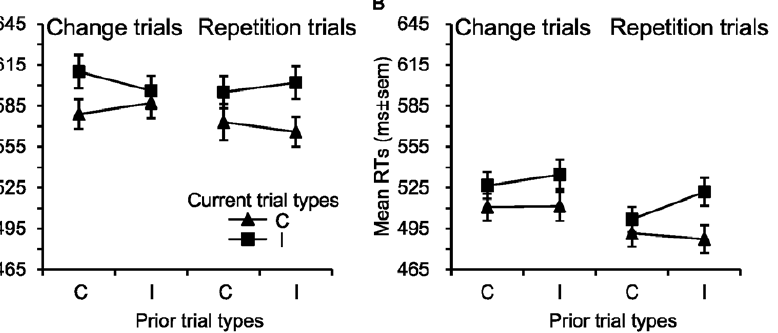
Figure 3. Mean RTs for correct trials as a function of previous trial types for response change trials and response repetition trials in the weakly masked and strongly masked groups. (A) Emotional conflict adaptation results in the weakly masked group. (B) Emotional conflict adaptation results in the strongly masked group. The classic emotional conflict adaptation effect was observed in the weakly masked group. The endpoint of the line chart depicts the mean RTs in each experimental condition. Error bars represent the standard error of the mean (SEM). C=Congruent, I=Incongruent.